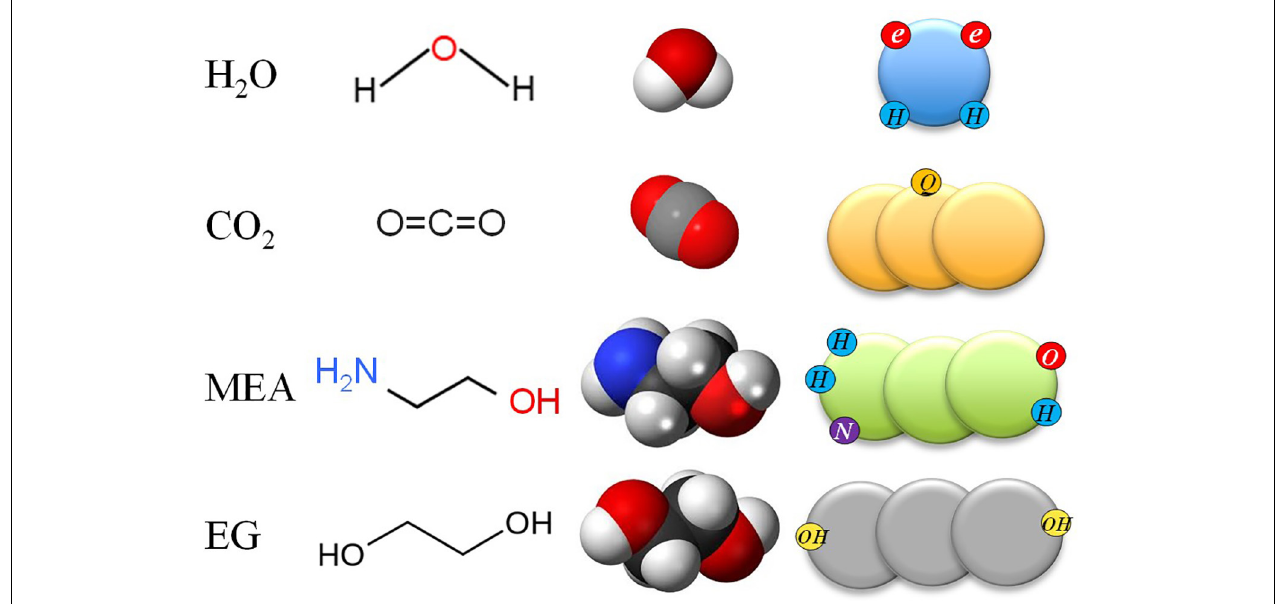
FIGURE 2 | Sketch of the soft-Statistical Associating Fluid Theory (SAFT) molecular models for four of the molecules investigated in this work, from to top to bottom: water, CO 2 , monoethanolamine (MEA), and ethylene glycol (EG). From left to right: acronym, chemical structure, 3D model, and soft-SAFT model. See text for